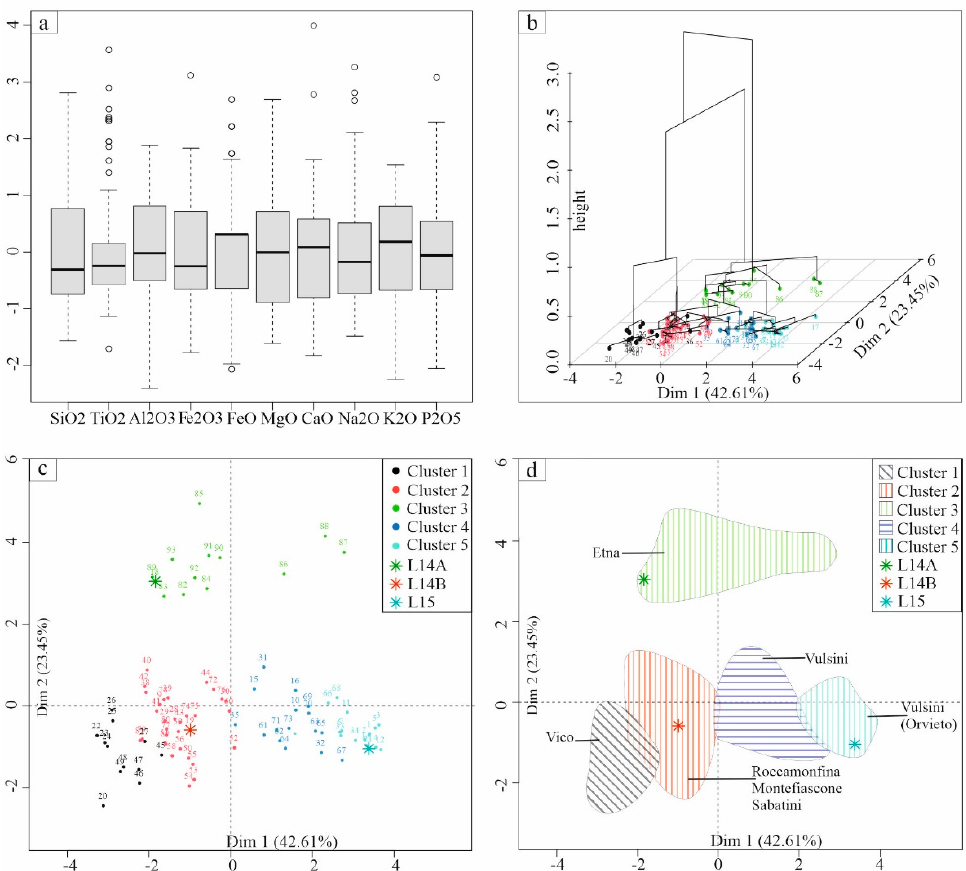
Figure 3. ( a ) Boxplot; ( b ) hierarchical clustering; ( c ) principal components analysis; ( d ) cluster analysis for a population of 100 rocks from literature selected as representative of potential sources of the investigated samples.